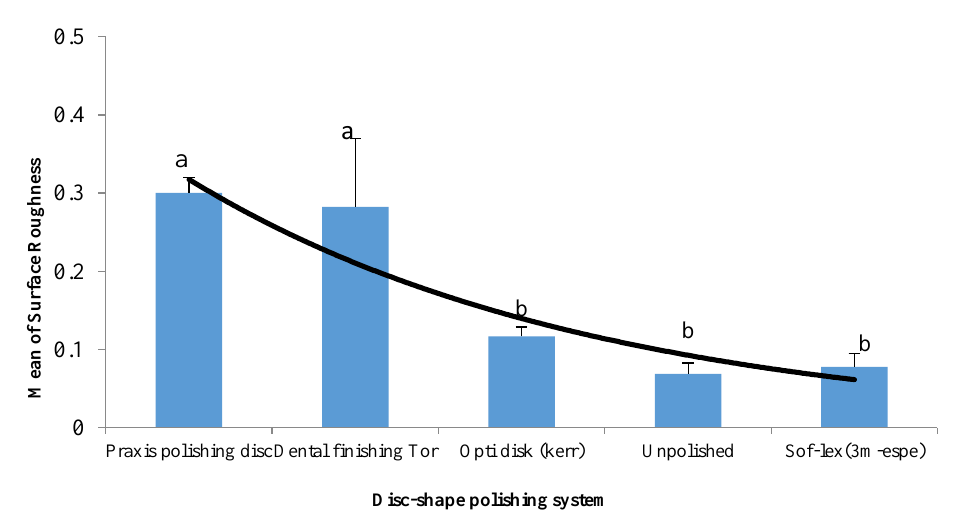
Fig. 1. Bar graph of the average surface roughness of nanohybrid composite according to disc-shaped polishing systems.